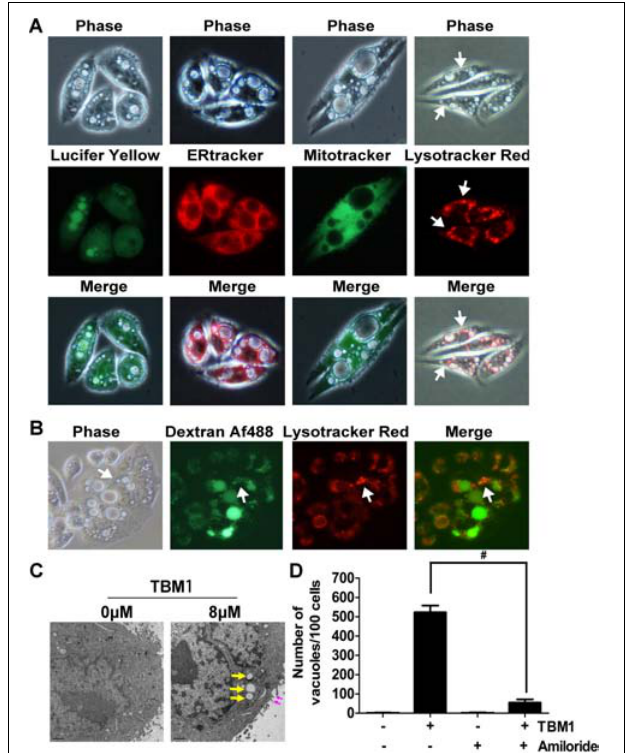
FIGURE 2 | The cytoplasmic vacuoles induced by TBM1 can be identified as macropinosomes. (A) SW480 cells were treated with 8 µ M TBM1 for 24 h and then incubated with Lucifer yellow or organelle tracers. In the left panel, some phase-lucent vacuoles incorporated Lucifer yellow. In the other panels, different organelle marker was used to label different compartment. The matching phase-contrast and fluorescent images were taken consecutively. (B) SW480 cells were treated with 8 µ M TBM1 for 24 h and then incubated with Dextran Af-488 for 4 h, washed, and finally cultured for 1.5 h with lyso-tracker Red. The phase-contrast image exhibited the same field of cells described in the fluorescent images. (C) SW480 cells were treated with 8 µ M TBM1 for 12 h and then observed by transmission electron microscopy. Yellow arrowheads indicated vacuoles. Purple arrowheads showed the extending lamellipodia was enclosing to form nascent macropinosomes. (D) SW480 cells were pre-cultured in presence or absence of